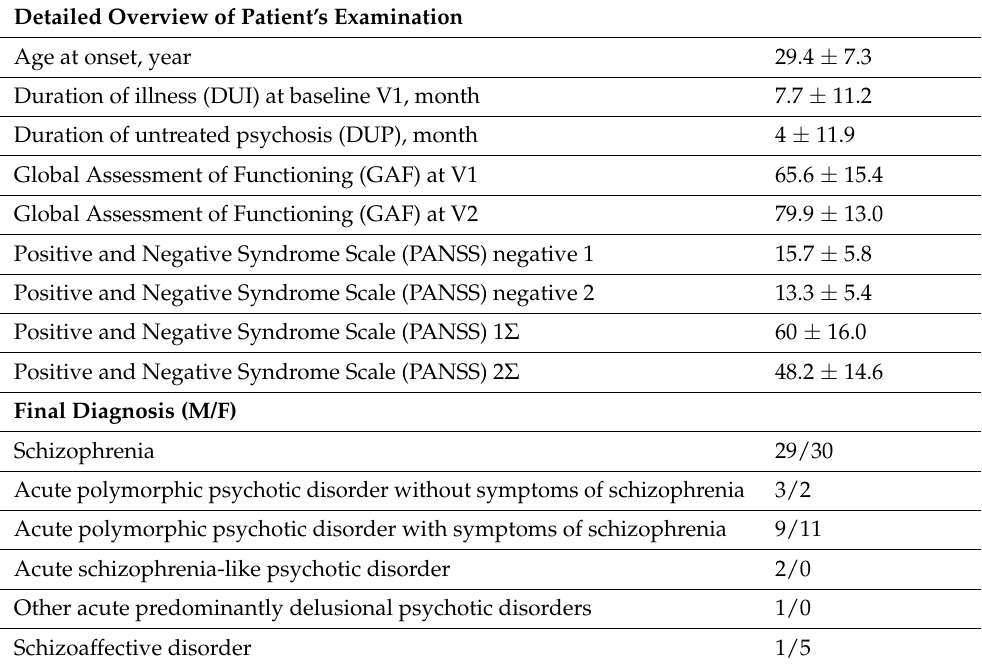
Table 2. Characteristics of the Patients and Diagnoses. The Data are Presented as Mean Values ±